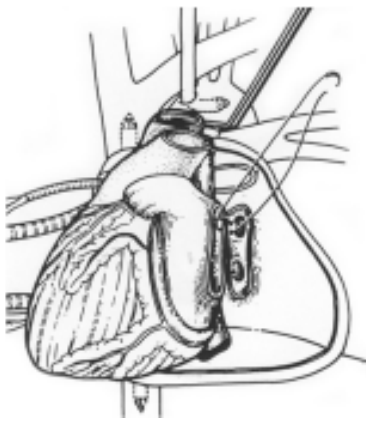
Fig. 3 – Anastomosis with the left pulmonary vein [9]. Fig. 5 – Anastomose with the superior vena cava [9].